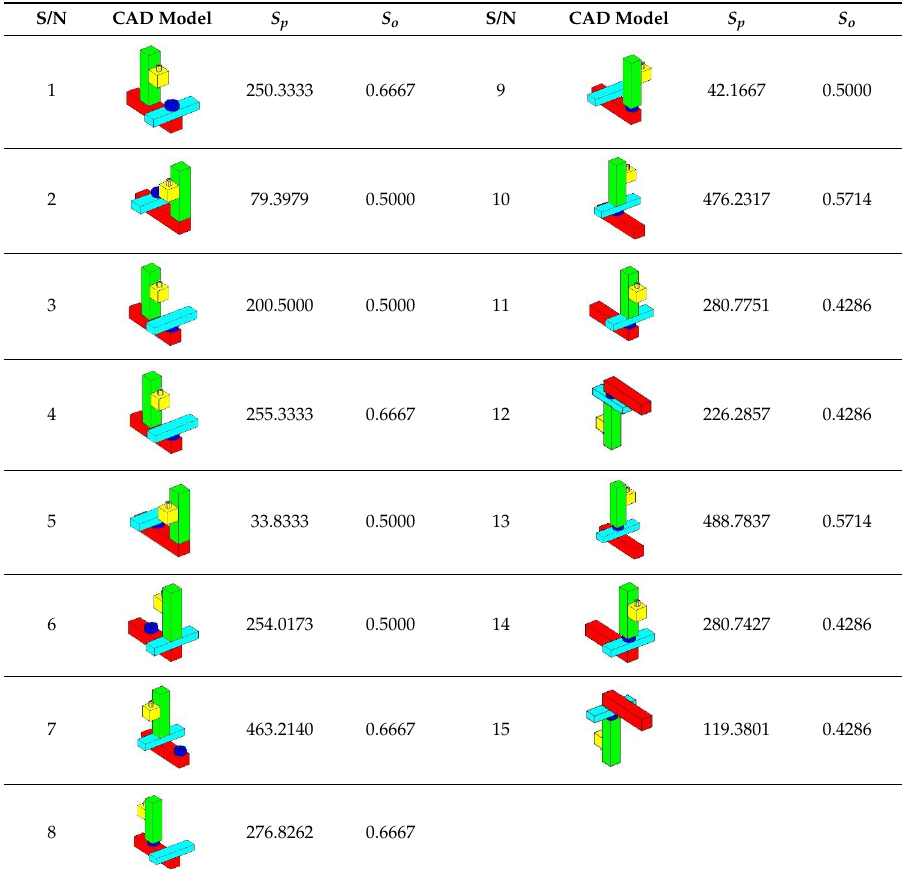
Table 9. Results of error sensitivity analysis.